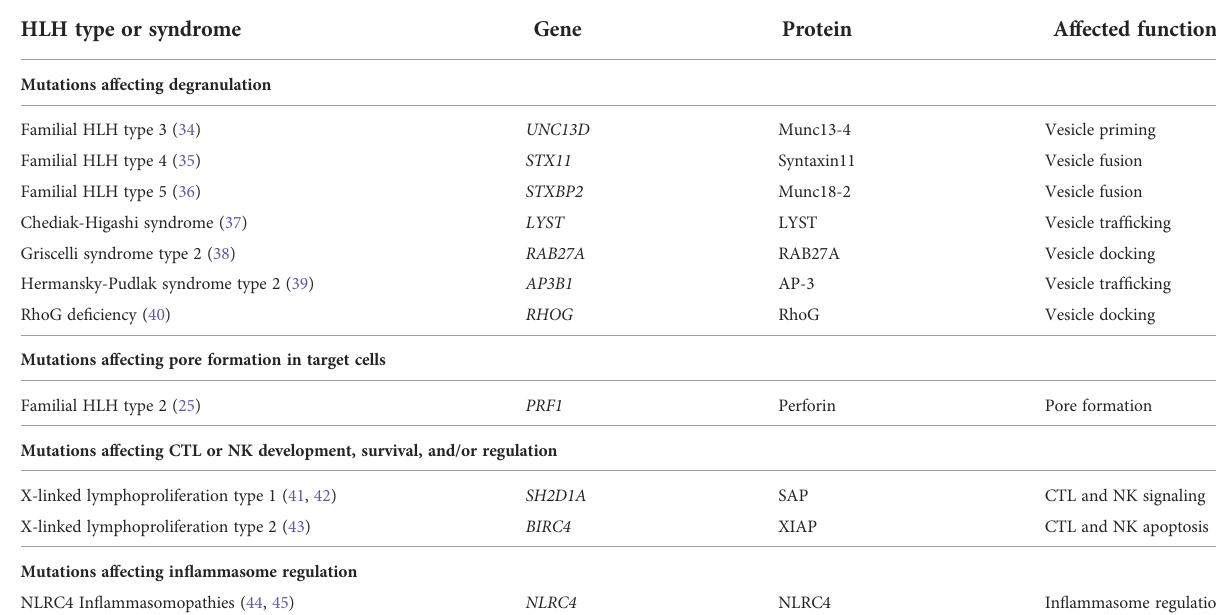
TABLE 2 Genetic mutations associated with primary